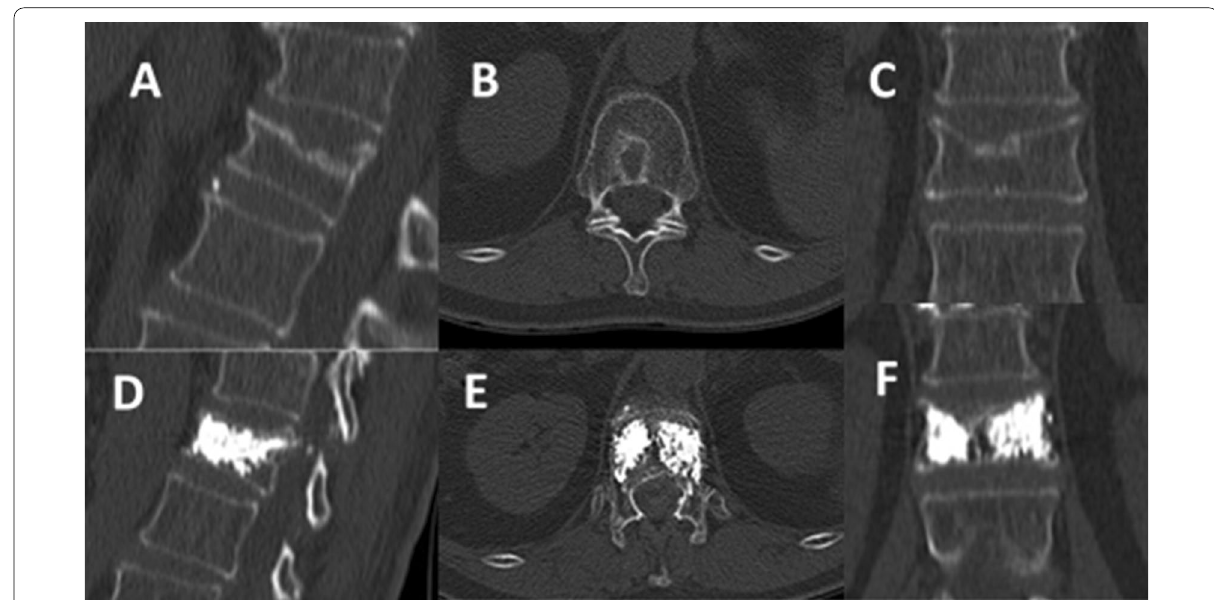
Fig. 3 Vertebroplasty of thoracic vertebral fracture (T12), OF type 1. A – C CT scan before surgery (sagittal, axial and coronal), D–F after surgery